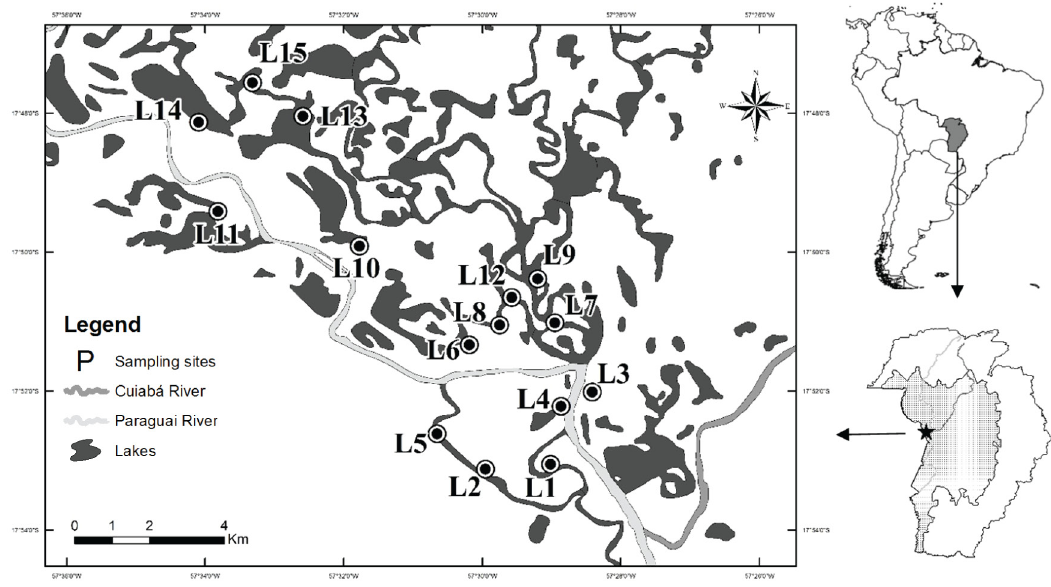
Figure 1. Map of location of the 15 marginal lakes along Paraguay River, on southeast Upper Basin Paraguay (BAP), in southwest part of MT State, Brazil, sampled in September of